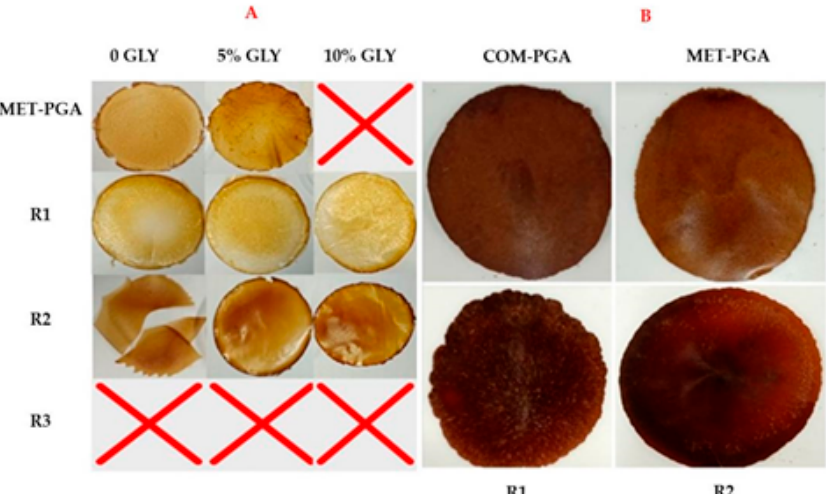
Figure 5. Films obtained by casting film forming solutions prepared with 800 mg of MET-PGA, R1, R2 and R3 γ -PGA fractions in the absence or presence of two different glycerol (GLY) concentrations; x, unhandleable sticky material ( A ). Films obtained by hot compression of 2 g of COM-PGA ( γ -PGA), MET-PGA, R1 and R2 powders mixed with 5% GLY ( B ). Further experimental details are given in the text.